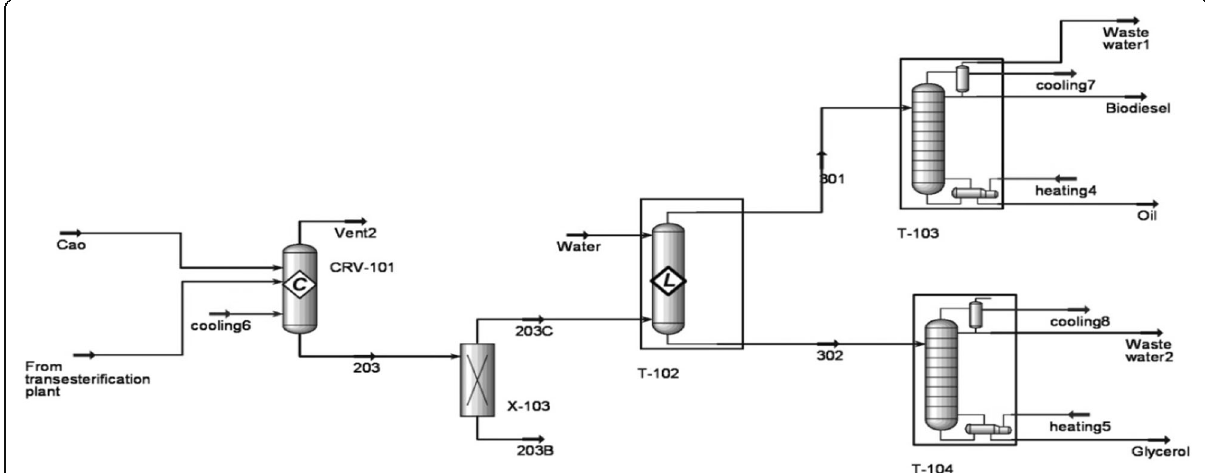
Fig. 5 Product purification flow sheet, where (CRV-101) neutralization tank, (X-103) settling tank, (T-102) water washing tower, (T-103) biodiesel